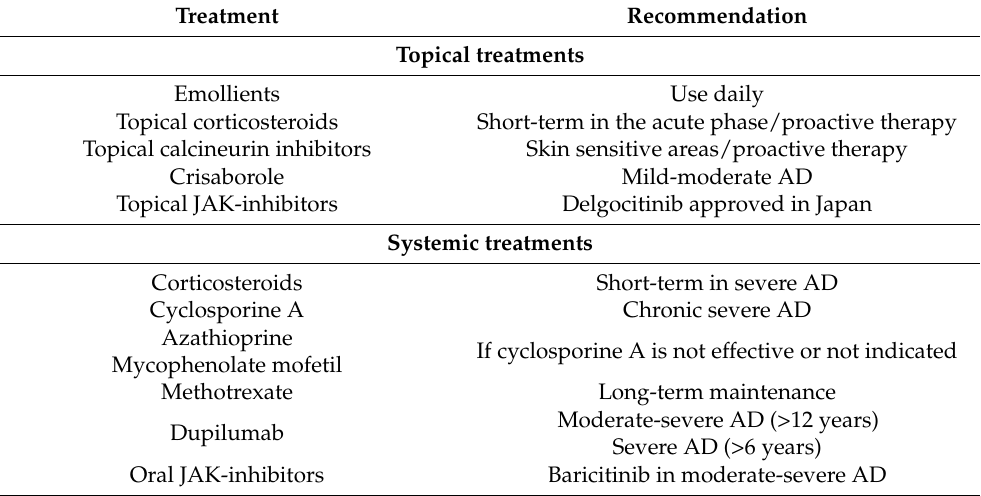
Table 1. Current available topical and systemic treatments in atopic dermatitis (as of September